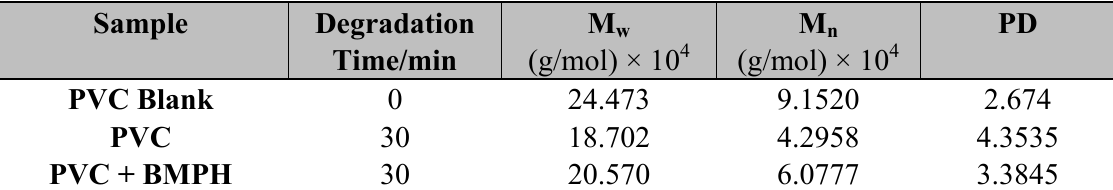
Table 3. GPC measurements of degraded PVC